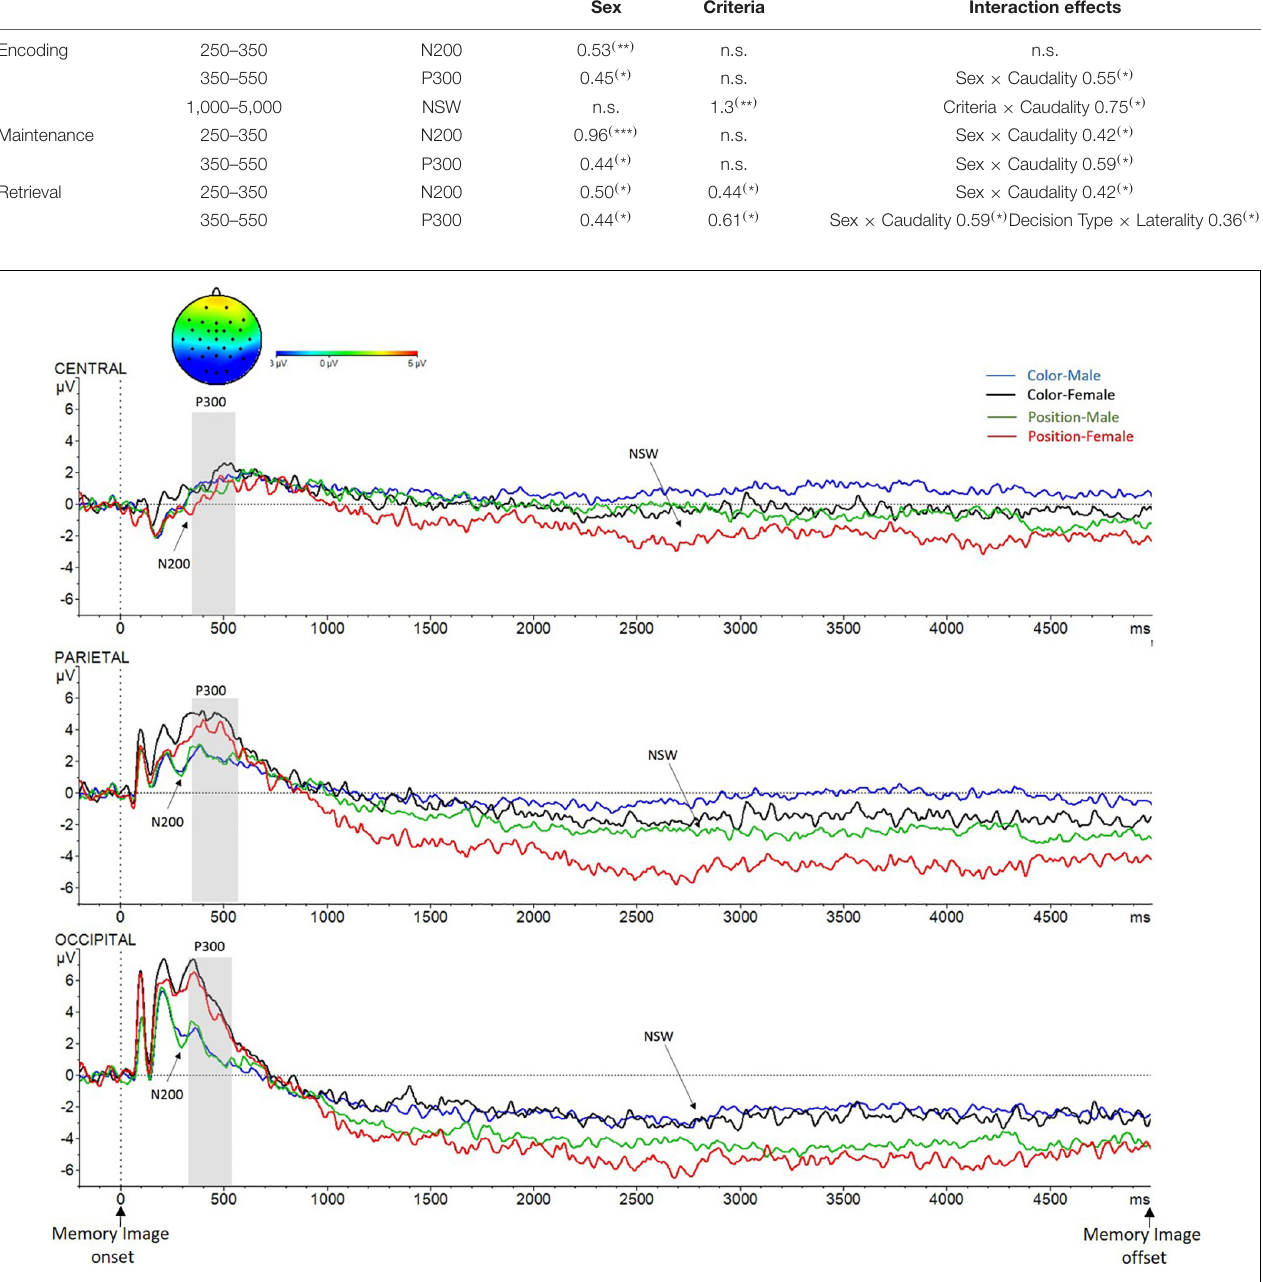
FIGURE 6 | Grand-average voltage data (in mV) of ERP in the Encoding phase in ROI, as a function of Criteria and Sex (Color_Men, blue line; Color_Women, black line; Position_Men, green line; and Position_Women, red line). Gray shades represent the P300 time window. On the top, topographic map of the difference in ERP waves due to Sex (Men–Women) in the P300 time window. NSW, negative-slow wave. Time zero represents Memory Image